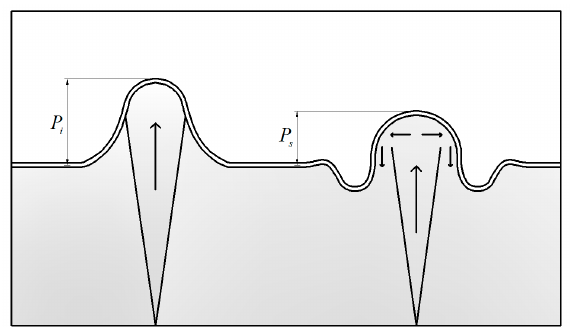
Figure 13. Schematic of the initial penetration height (left) and the stable penetration height (right).